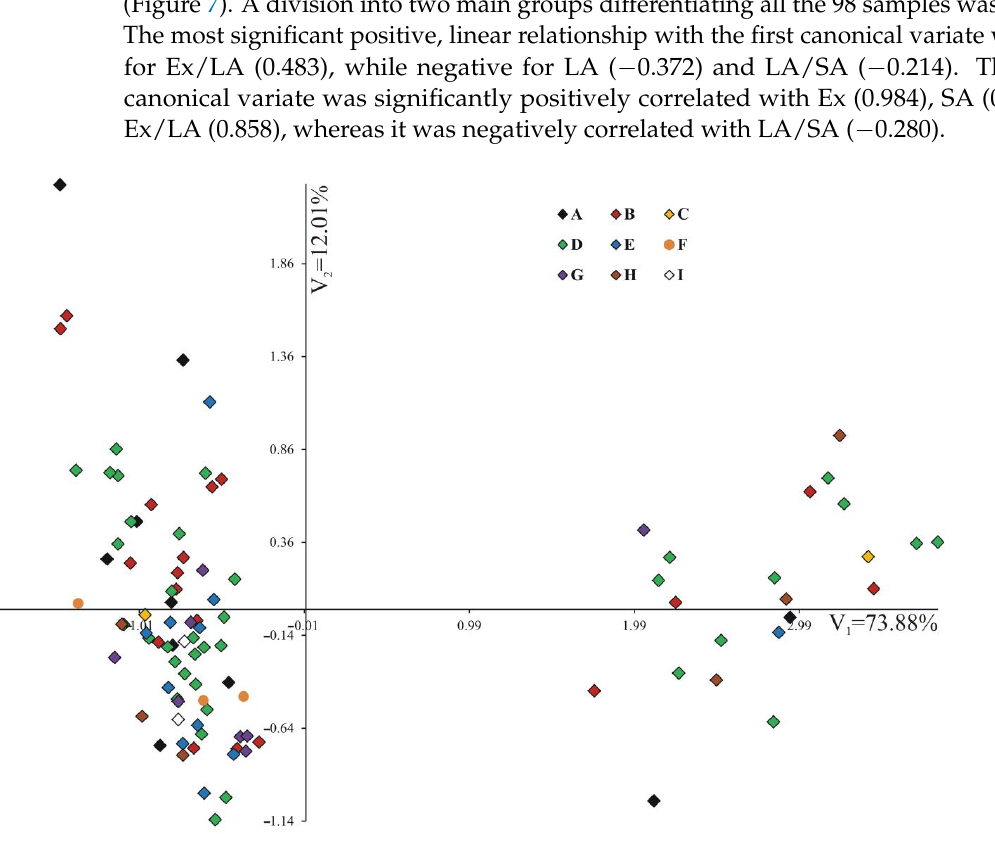
Figure 7. Distribution of 98 samples in the space of the first two canonical variables (V 1 and V 2 ), A-I abbreviated habitat names (see: Table